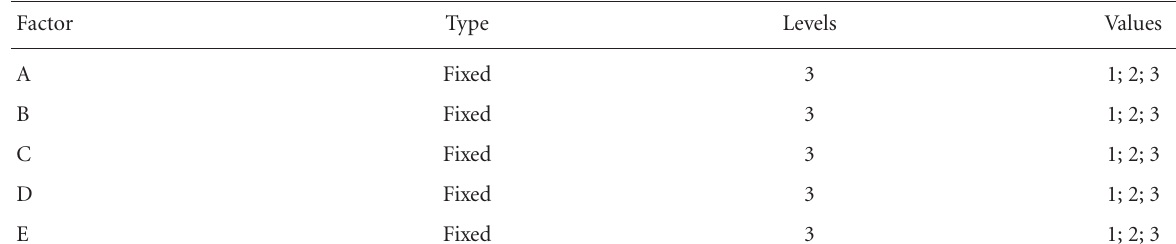
Table 4: The analysis of variance (ANOVA) table.